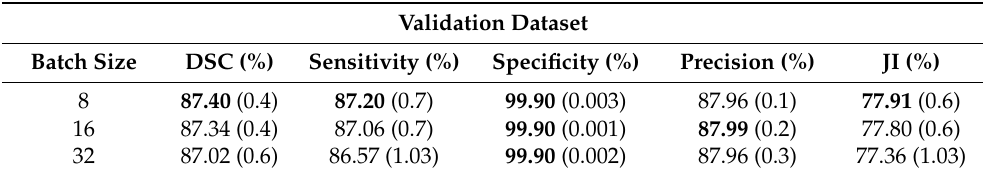
Table 6. Obtained values of five segmentation metrics using three batch sizes of 8, 16, and 32 with the RMSProp optimizer after 400 epochs of running MobileUNetV3.